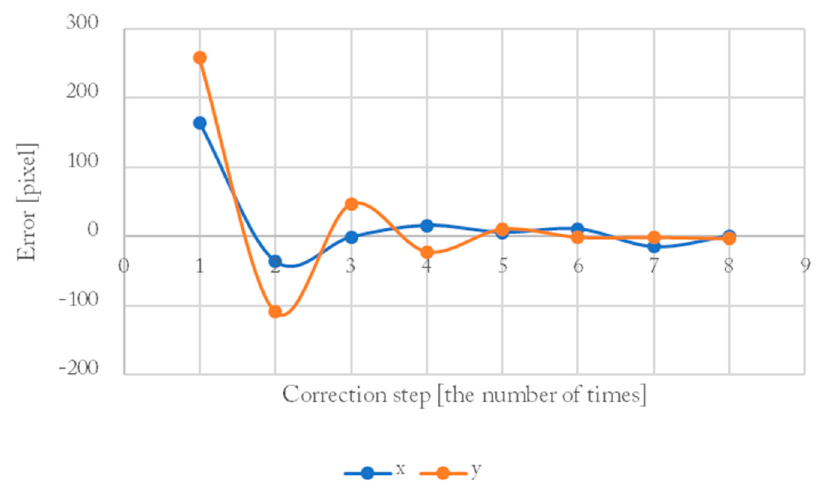
Figure 19. The error of pixels in the image according to the number of repetitive controls that occurs when moving the end-effector to the target point.